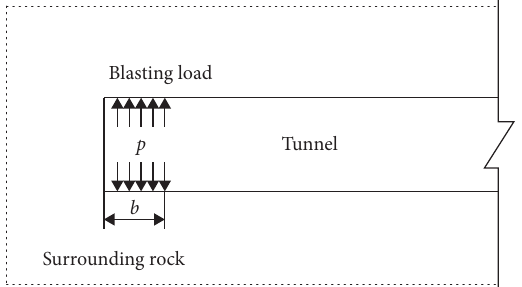
Figure 1: Calculation model of seismic wave